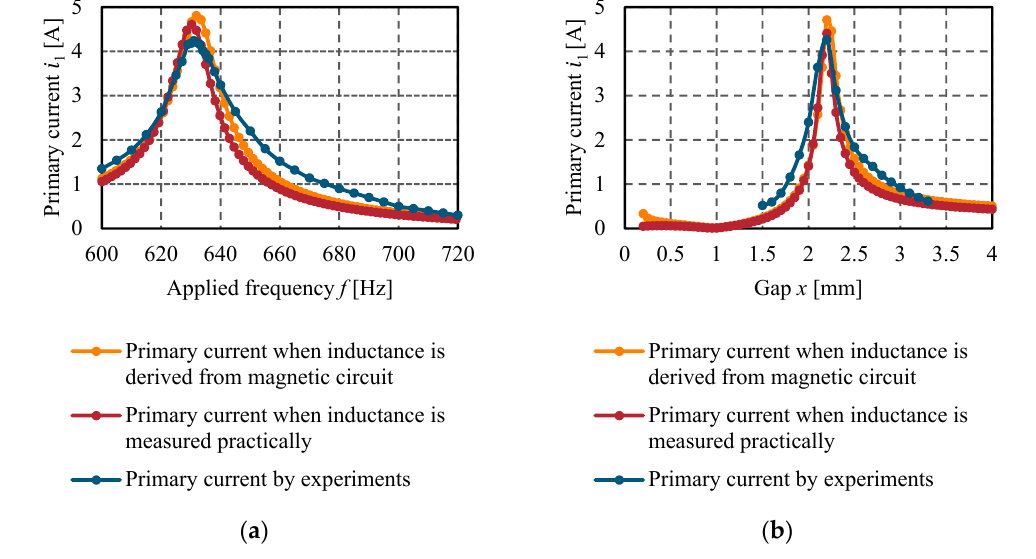
Figure 10. The comparison of the characteristics curve of the primary current: ( a ) when the gap x is 2.0 mm; ( b ) when the applied frequency f is 650 Hz.